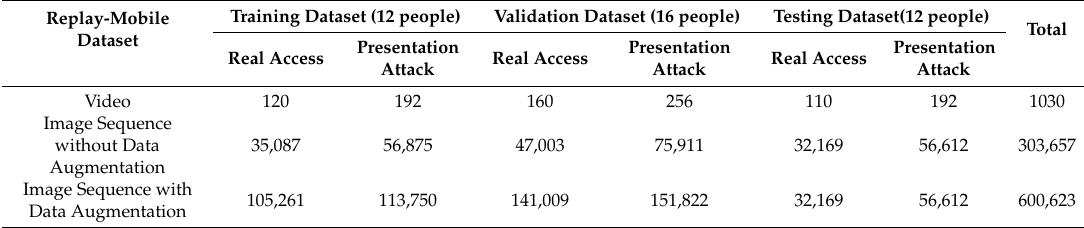
Table 5. Description of the Replay-mobile dataset used in our study (unit: image